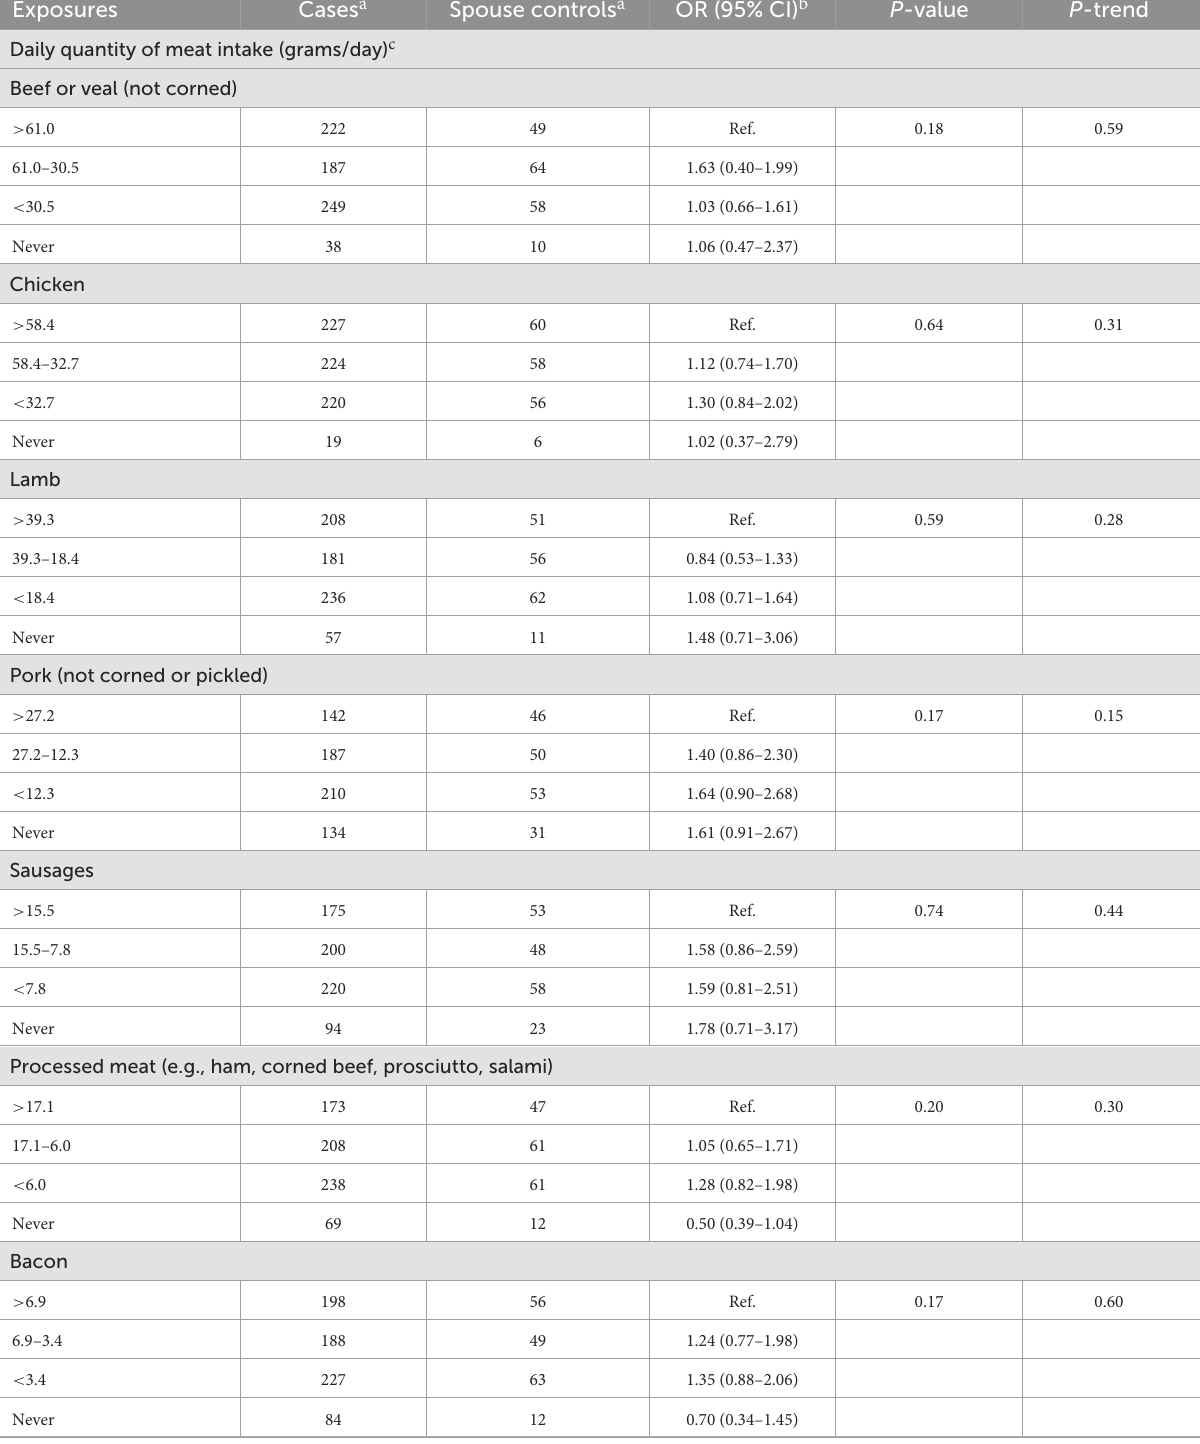
TABLE 3 Odds ratios and 95% confidence intervals for the likelihood of FL in relation to meat consumed in the year before last among cases and spouse controls.